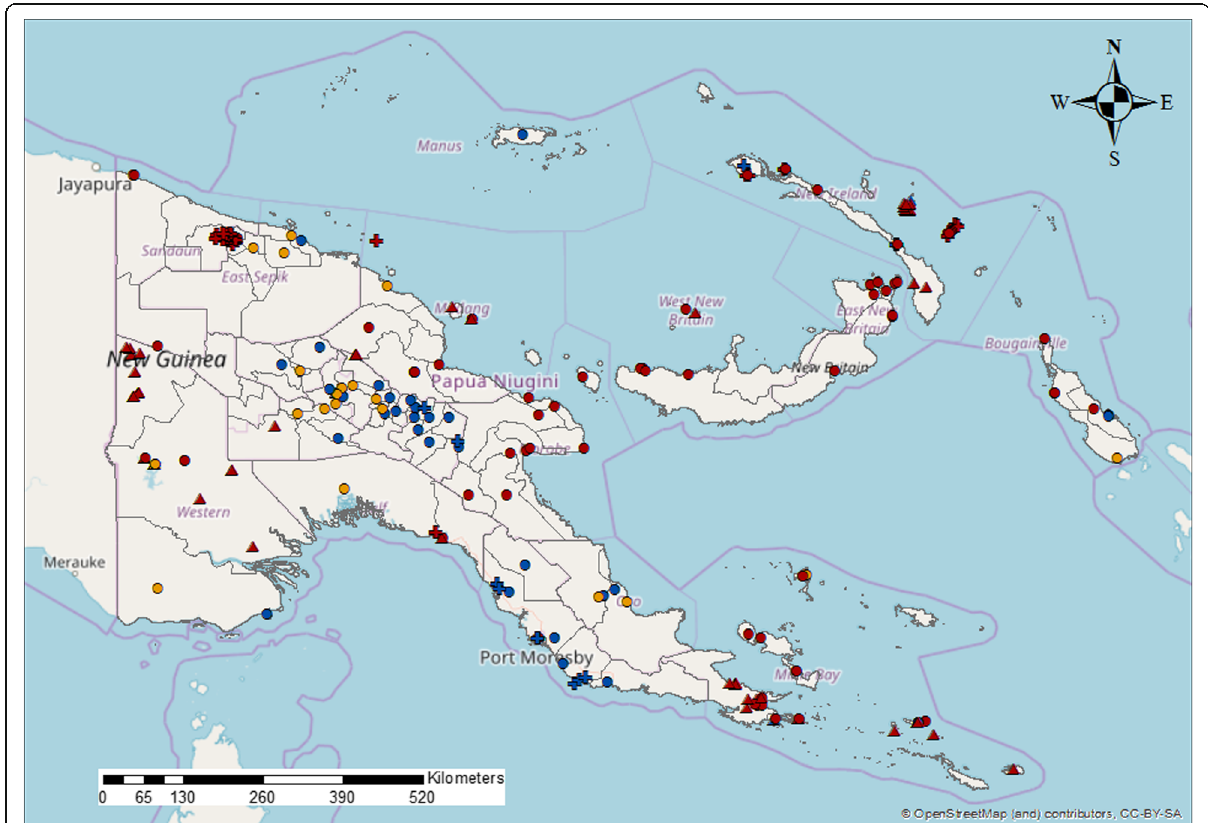
Fig. 5 Distribution from surveys conducted: (a) between 1990 and 1999 (triangles), (b) between 2000 and 2009 (circles) and (c) between 2010 and 2014 (crosses). No or very low (< 1%), low (1 to 5%) and high (> 5%) prevalence categories are represented by blue, orange and dark red,